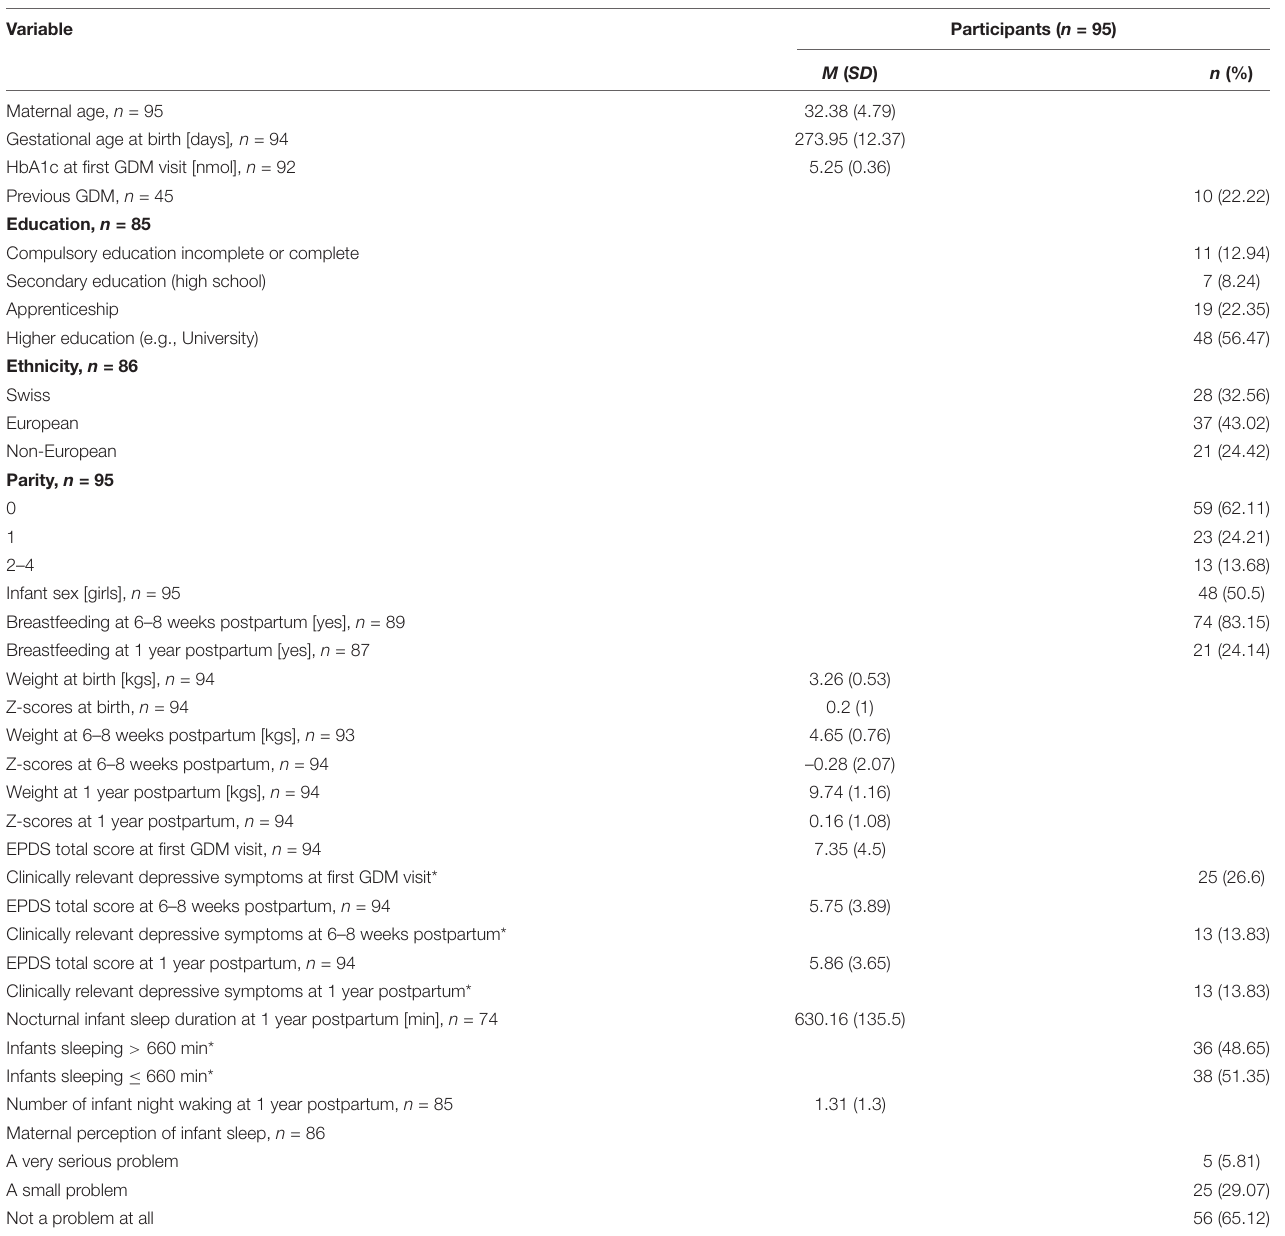
TABLE 1 | Descriptive sample